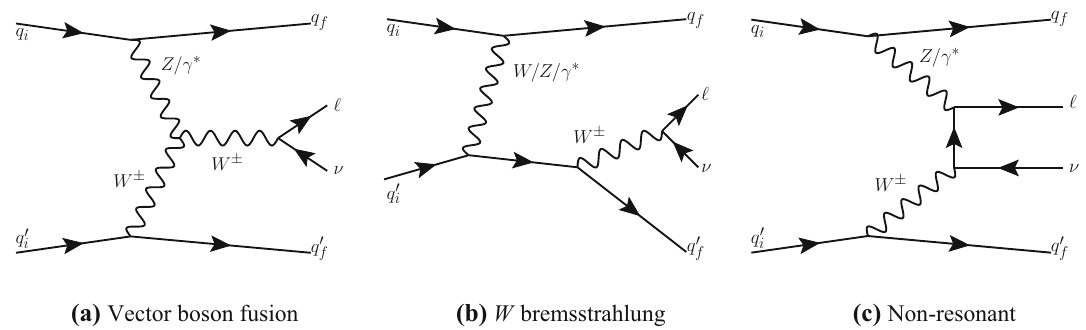
Fig. 1 Representative leading-order diagrams for electroweak W jj production at the LHC. In addition to a the vector boson fusion pro- cess, there are four b W bremsstrahlung diagrams, corresponding to